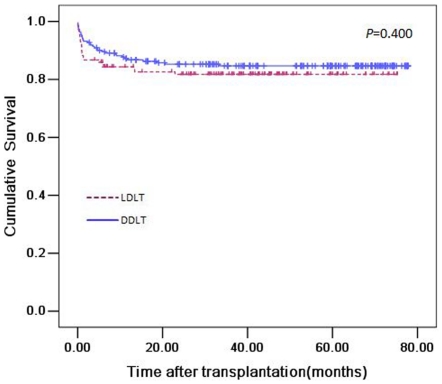
Survival curves of patients undergoing LDLT versus DDLT (P = 0.400).